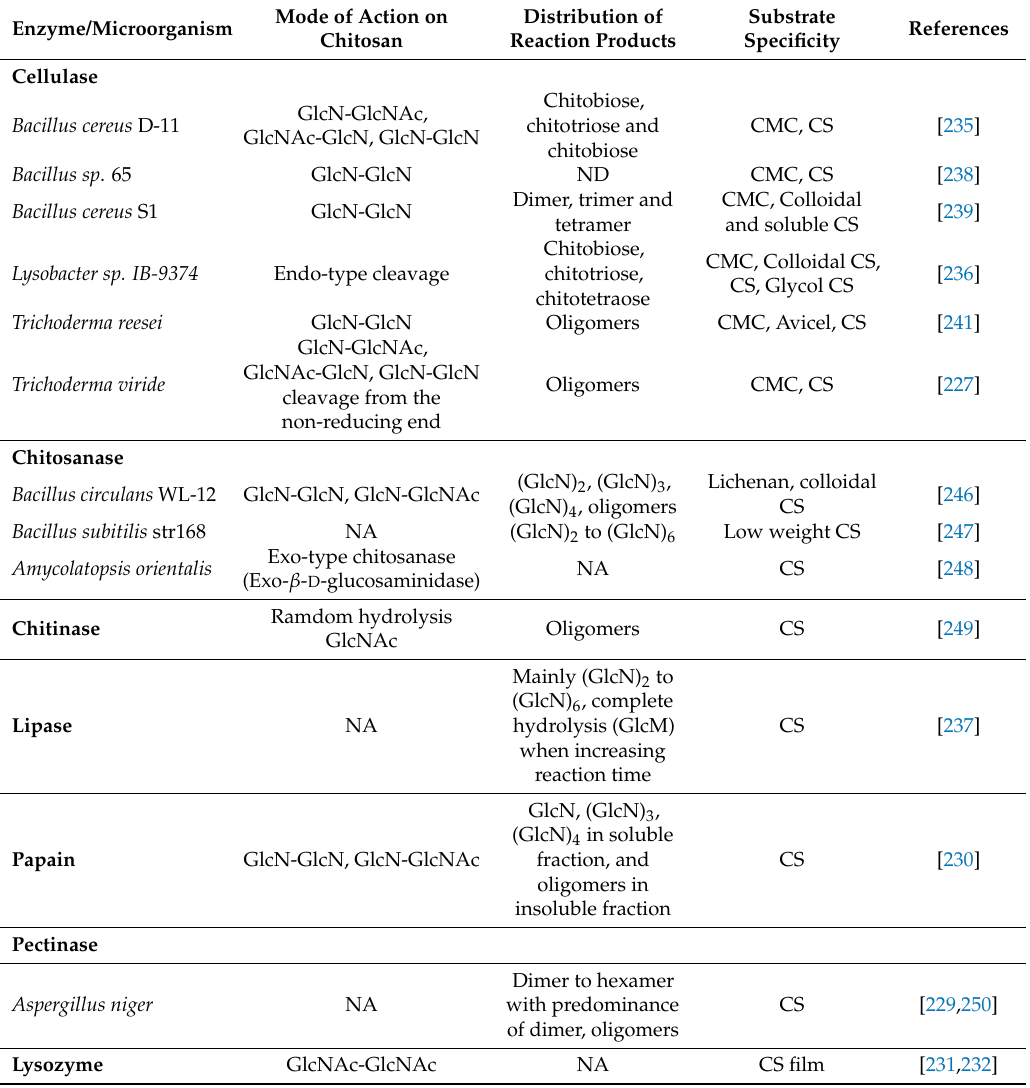
Table 4. Non-exhaustive list of enzymes biodegrading